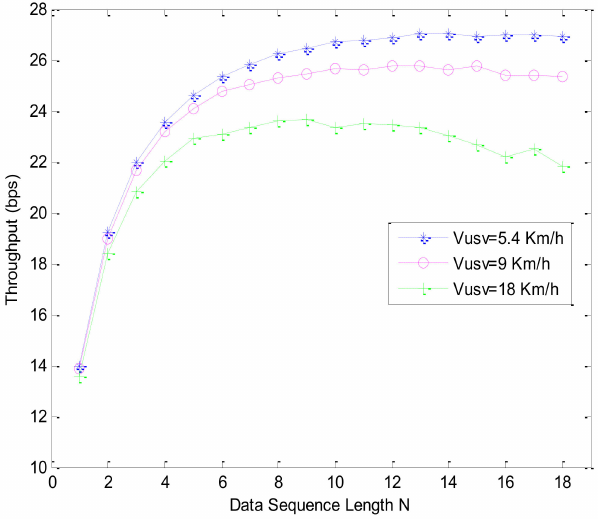
Figure 10. Protocol throughput simulation for data sequence length N and velocity of USV.